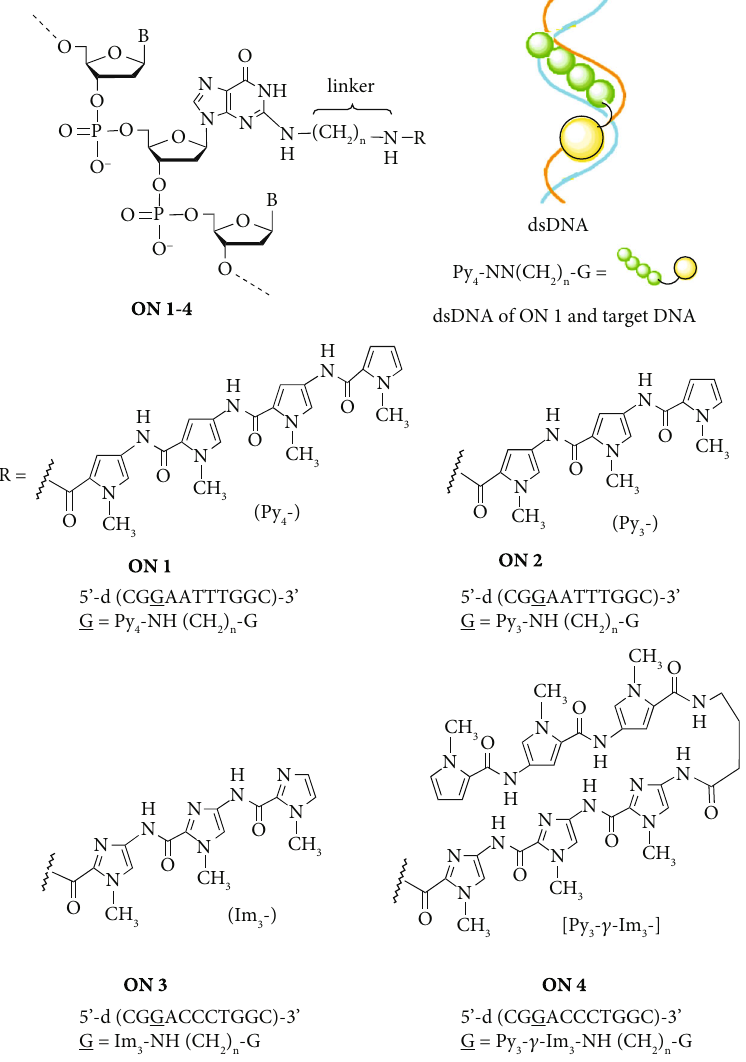
Figure 2: MGB polyamide-oligonucleotide